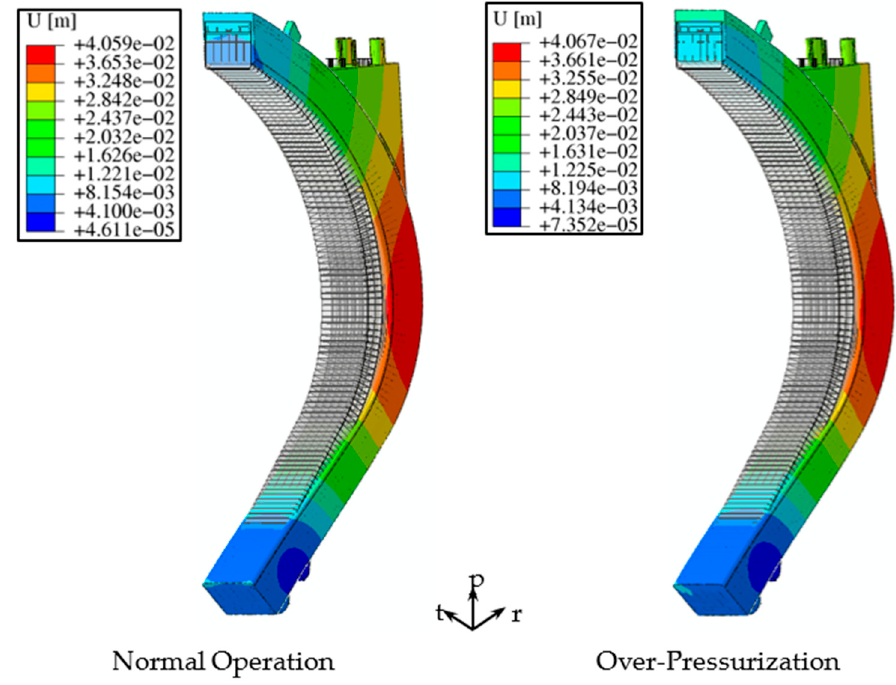
Figure 13. Deformed vs. Undeformed shapes under NO and OP loading scenarios.